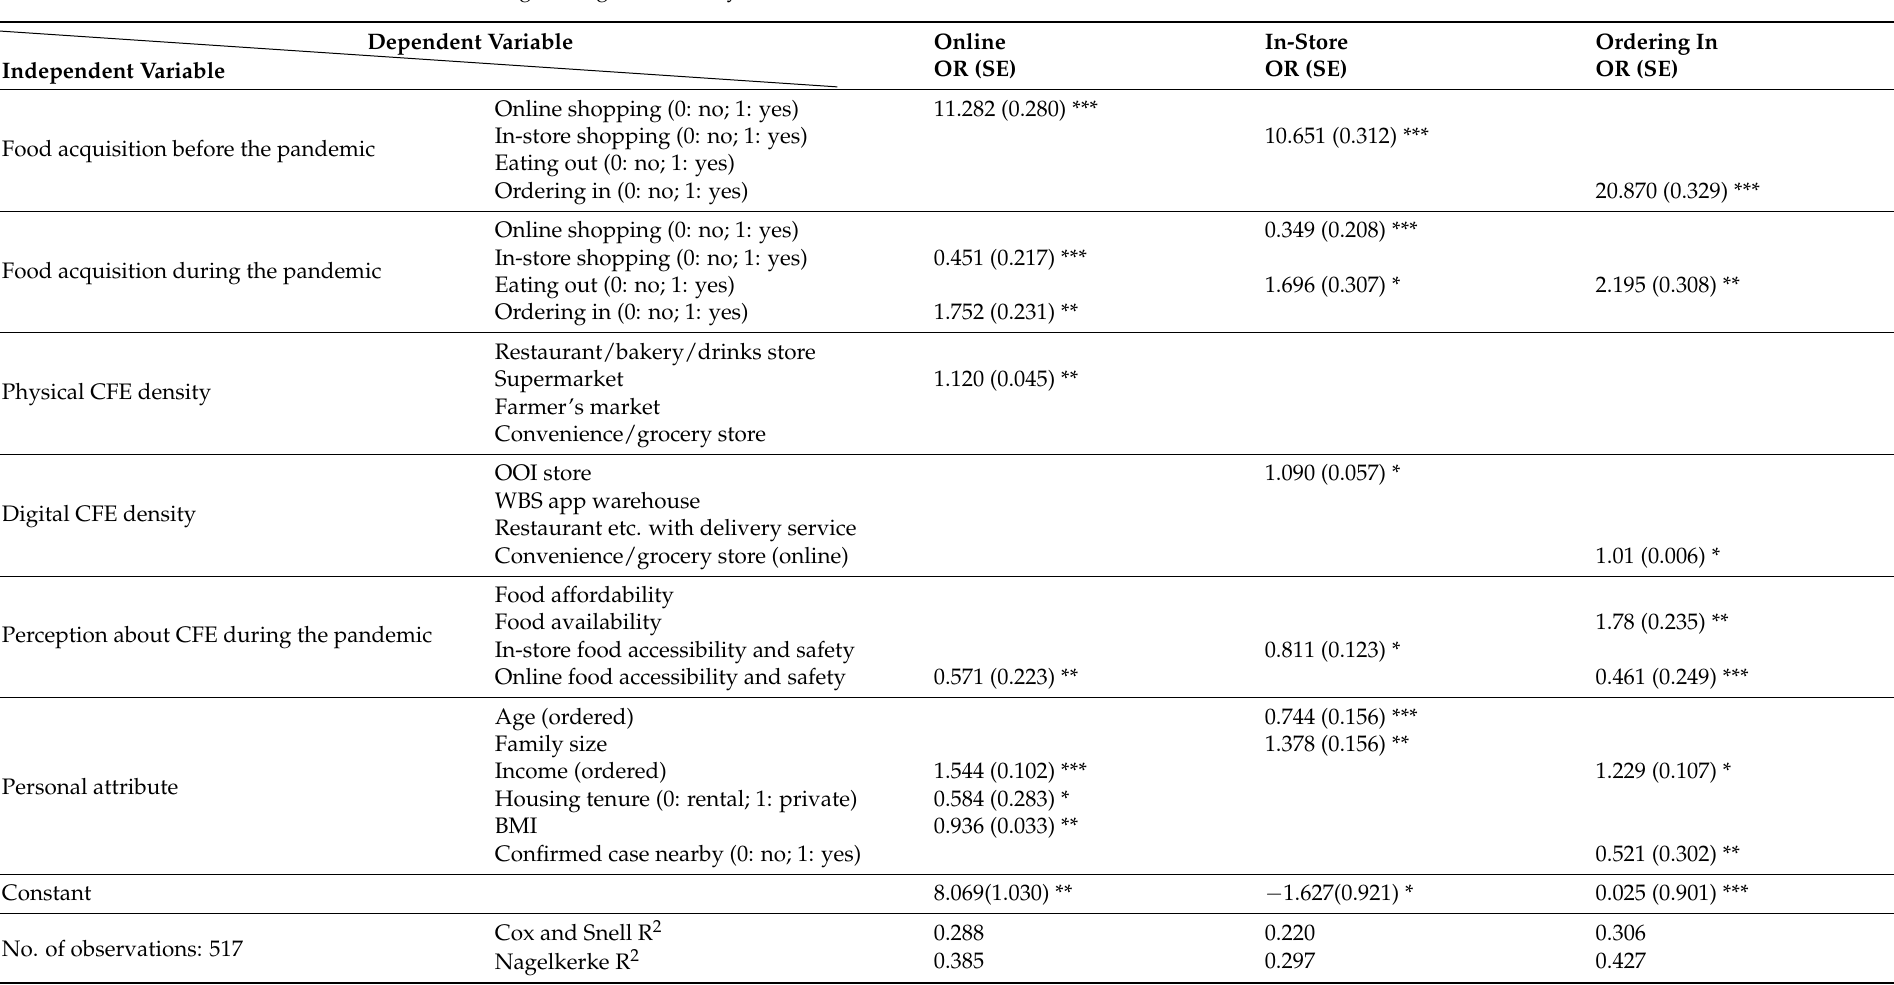
Table 6. Results of logistic regression